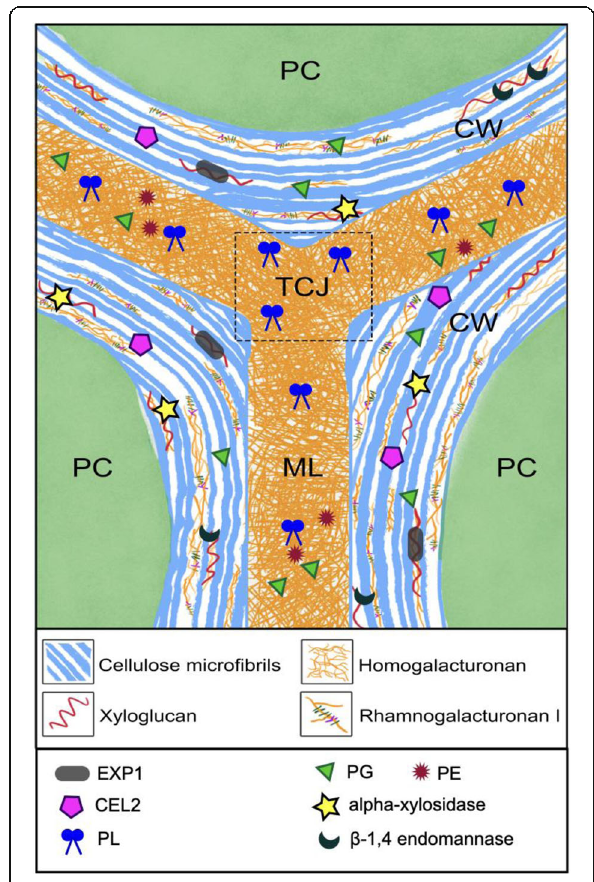
Fig. 2 Tomato pericarp cell wall and some of the key enzymes involved in softening. Cellulose microfibrils are closely associated with pectin including homogalacturonan (HG) and rhamnogalacturonan I (RG-1I. HG chains can aggregate into highly organised structures and link to RG1 cores. The xyloglucans form “ biomechanical hotspots ” at limited locations in the CW, and tether cellulose microfibrils together. HG is present throughout the wall and especially in the middle lamella (ML) and the tricellular junctions (TCJ). Expansin, CEL2, alpha-xylosidase and β -1,4 endomannase are necessary for disrupting the associations between matrix polysaccharides and cellulose microfibrils. HG in TCJ and ML is disrupted by the combined activities of PL, PE and PG, allowing cell separation during tomato fruit softening. Based on evidence from tomato and other plant species including work reported